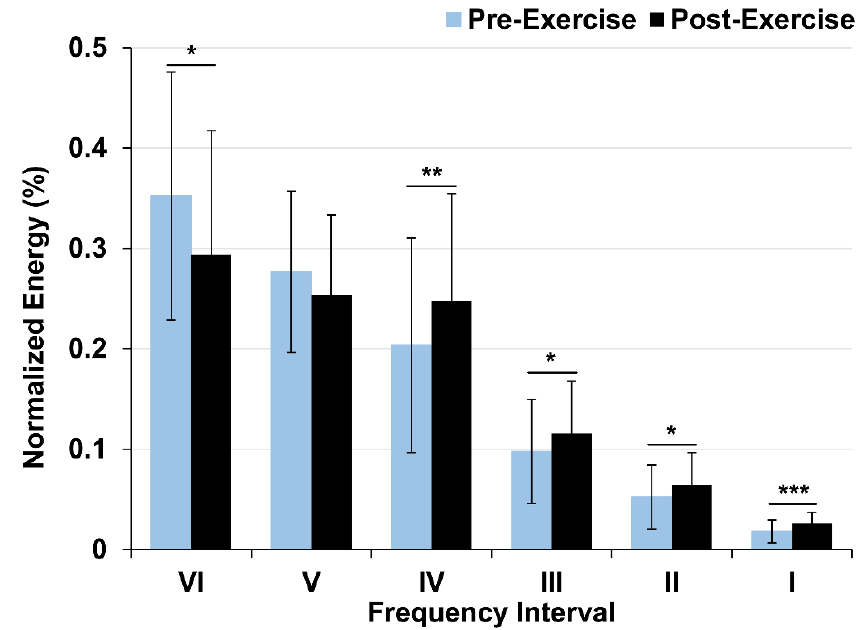
Figure 4. ( A ) Original TOI signals measured during the 30-min pre-exercise (gray line) and post- exercise (black line) rest phase. ( B ) Comparison of mean TOI values between pre-exercise (gray bar) and post-exercise (black bar) rest phase. Statistical significance: *** p < 0.001.